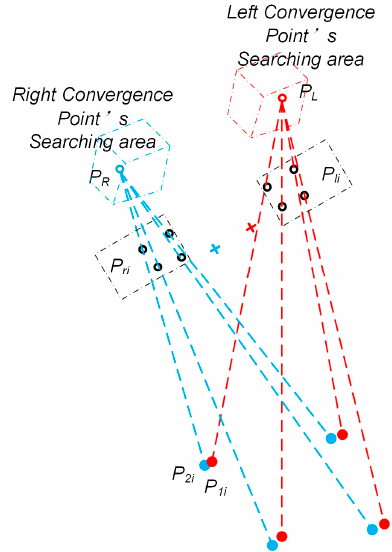
Figure 10. The illustration of the line-of-sight convergence point method and the searching area. P li and P ri are the centers of the left and right eyes’ pupils, P L and P R are the line-of-sight convergence points, and P 1 i and P 2 i are the nearest points of two lines which cover P L and P li , as well as P R and P ri . In our method, P L and P R would be searched in restricted areas, while P 1 i and P 2 i are known.